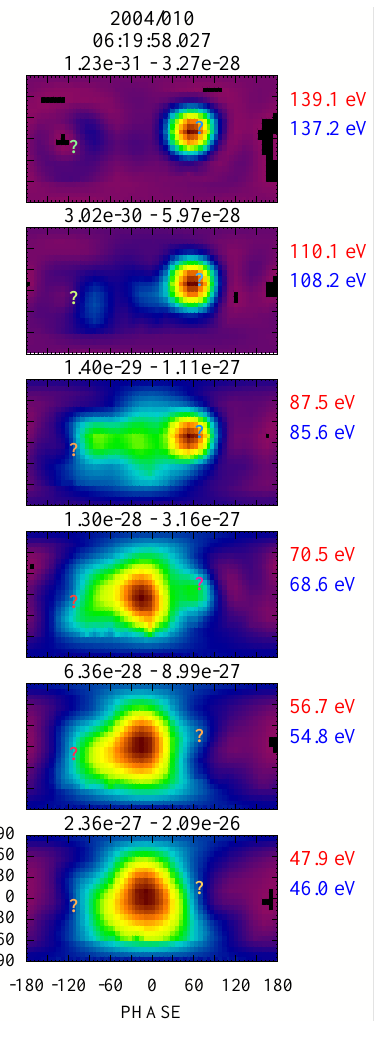
Fig. 8. A set of PT plots from within the time frame identified in Sahraoui et al. (2010) as containing oblique kinetic Alfv´en waves showing intense